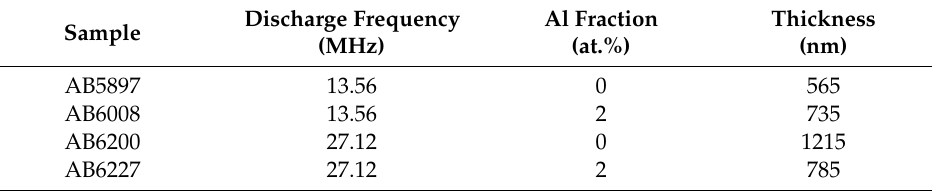
Table 1. Overview of the investigated ZnO samples and their parameters.